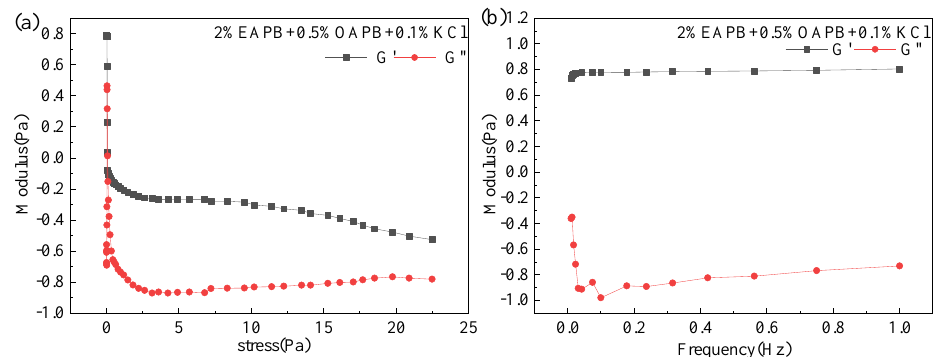
Figure 10. ( a ) Dynamic stress scanning results. ( b ) Dynamic frequency scanning results. (The modulus in the figure is taken as the value after l g).